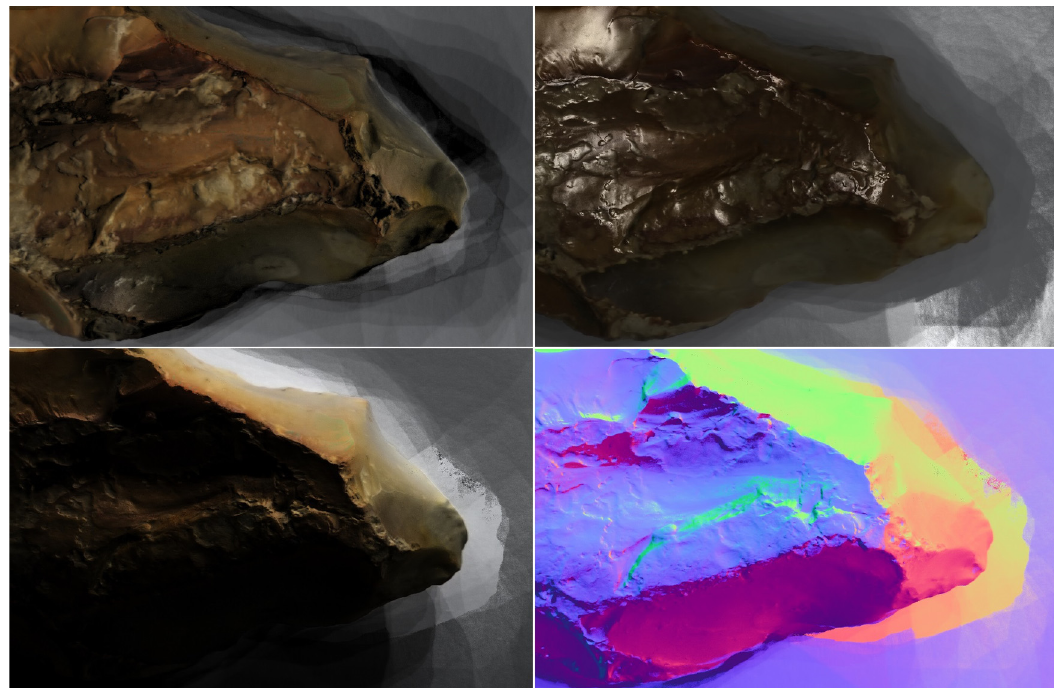
Figure 5: Example render modes of same part of